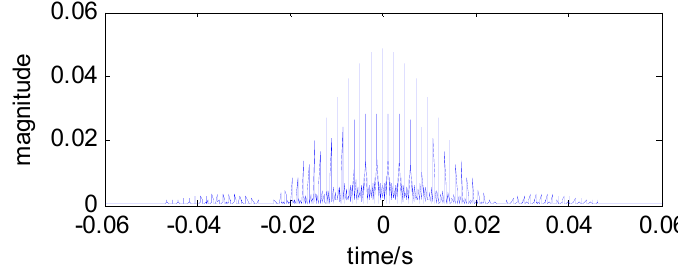
Figure 4. The time-domain plot of a comblet filter with =6 comb